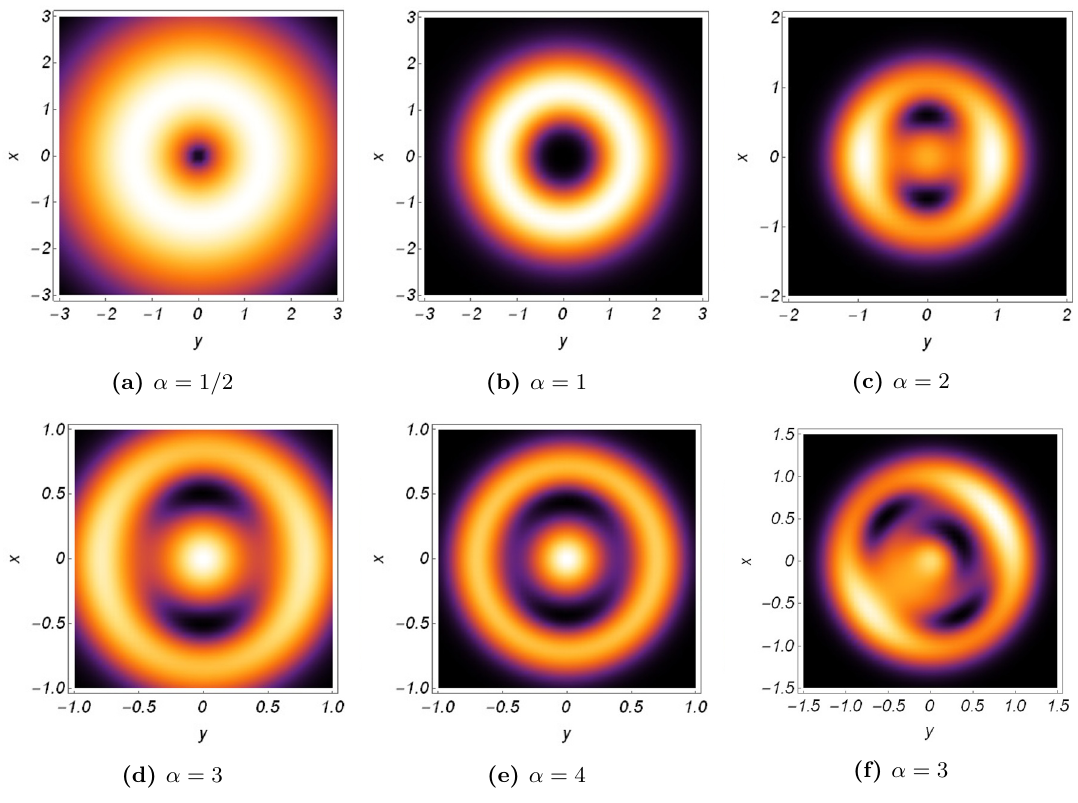
Figure 4. Density plots of the function | ψ ( α ) a | 2 /N for different values of α are shown in figures 0 ,a 1 ,a 2 from 4a to 4e, and the coefficients a j are chosen according to table 1. In figure 4f we consider the density plot of the function | ψ ( α ) a | 2 /N with α = 3 , where the complex values a i with 0 ,a 1 ,a 2 ,a 3 i = 0 , . . . , 3 are such that I a = 0 . 073 . Bright (dark) colours indicate maximum (minimum) 0 ,a 1 ,a 2 ,a 3 values of this function. Note that as α grows from 0 < α ≤ 1 to α = 2 , 3 , . . . , a local maximum appears in the origin of coordinates and the two appearing vortices seem to degenerate in one single region without